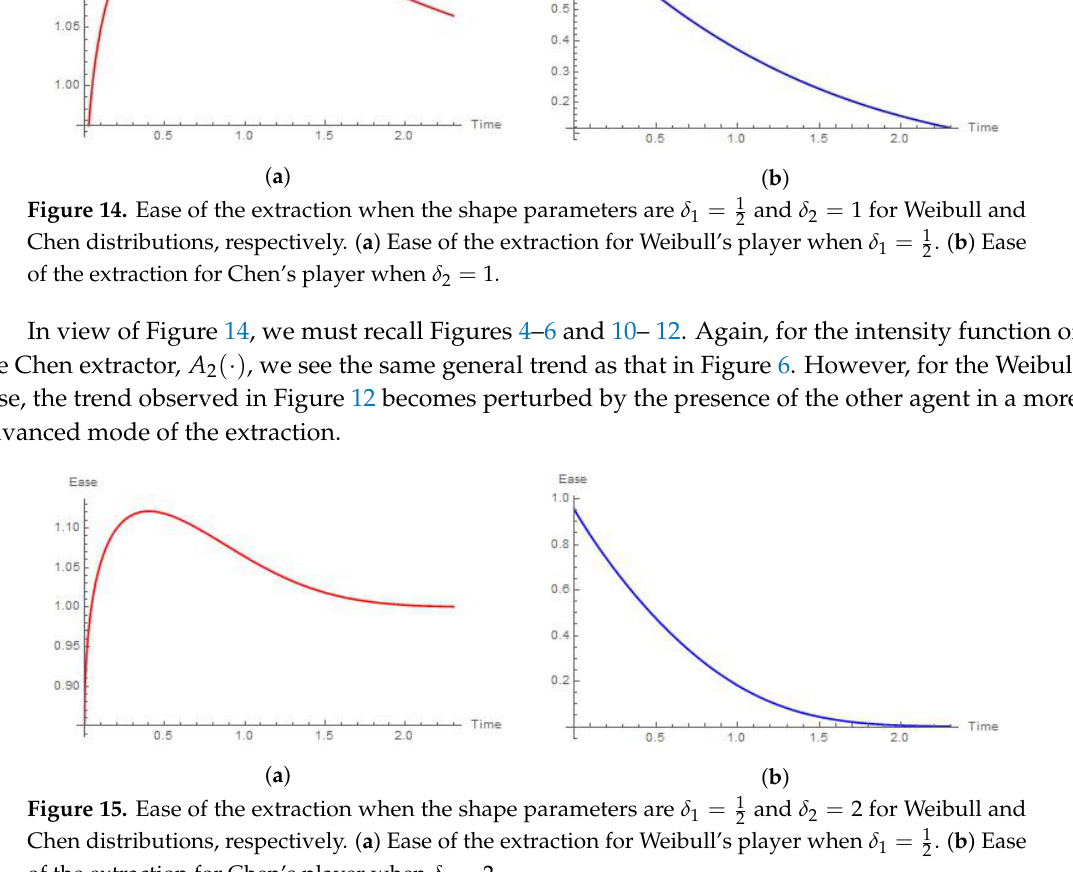
Figure 15. Ease of the extraction when the shape parameters are δ 1 = 1 Chen distributions, respectively. ( a ) Ease of the extraction for Weibull’s player when δ 1 = 1 of the extraction for Chen’s player when δ 2 =